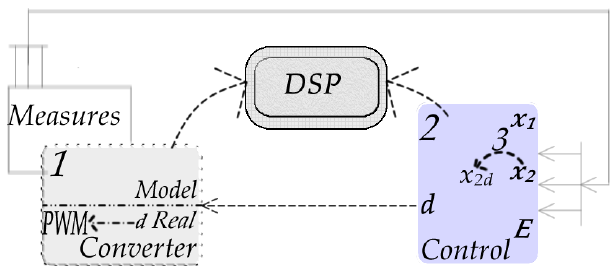
Figure 9. General SHIL Simulation Scheme.